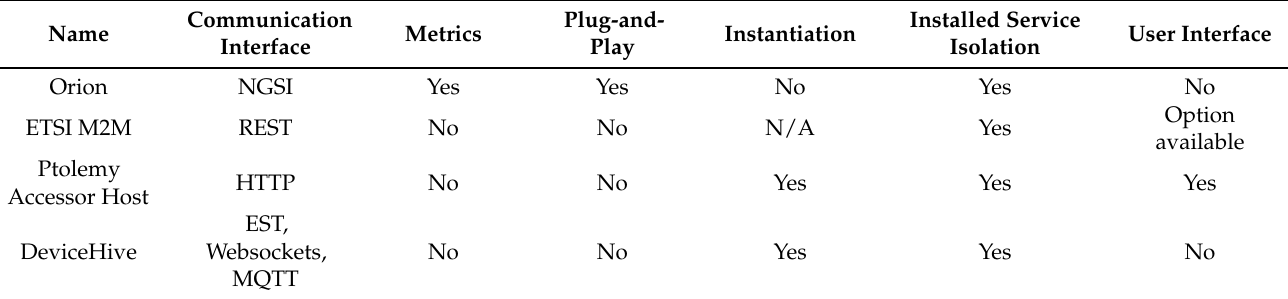
Table 1. Comparison of IoT middleware